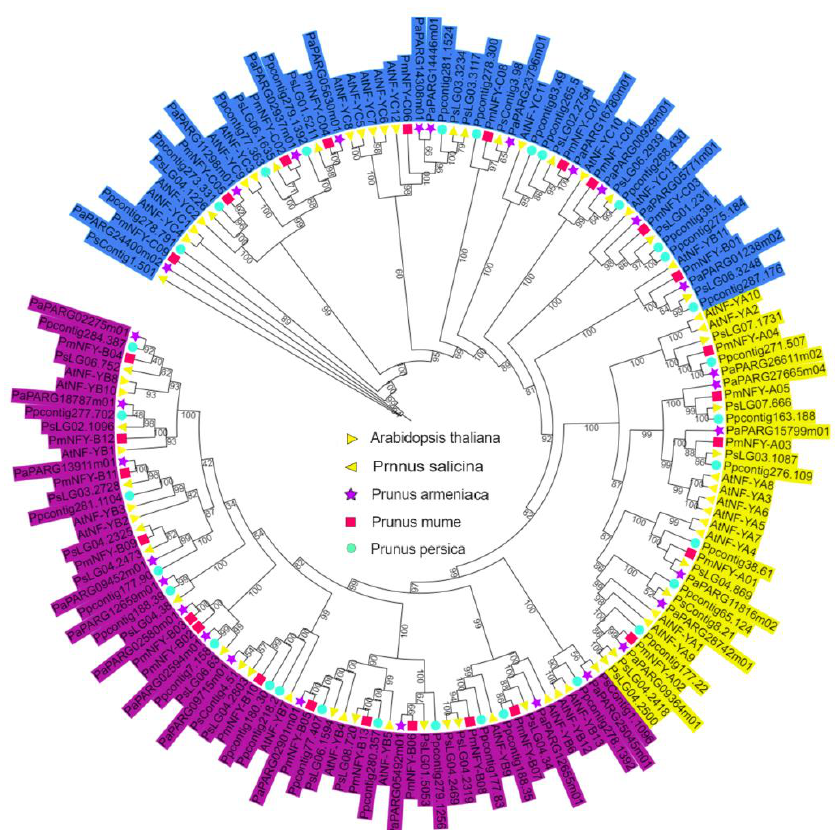
Horticulturae 2022 , 8 , x FOR PEER REVIEW Figure 6. Phylogenetic analysis of NF-Y proteins from Prunus mume and four other plant species.